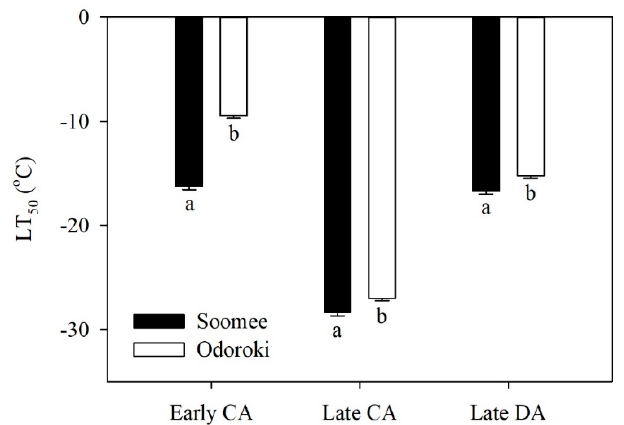
Figure 1. Seasonal changes in LT 50 values determined by electrolyte leakage analysis of the ‘Soomee’ and ‘Odoroki’ peach tree shoots during cold acclimation (CA), from early to late CA, and deacclimation (DA), from late CA to late DA. Vertical bars are the standard errors of the means ( n = 30). Different letters indicate significant differences within the same physiological stages using the Student’s t -test at p < 0.01. Table 1. Transcriptome sequencing data statistics from the ‘Soomee’ peach tree shoots during cold acclimation (CA), from early to late CA, and deacclimation (DA), from late CA to late DA. Physiological Stage Total Read